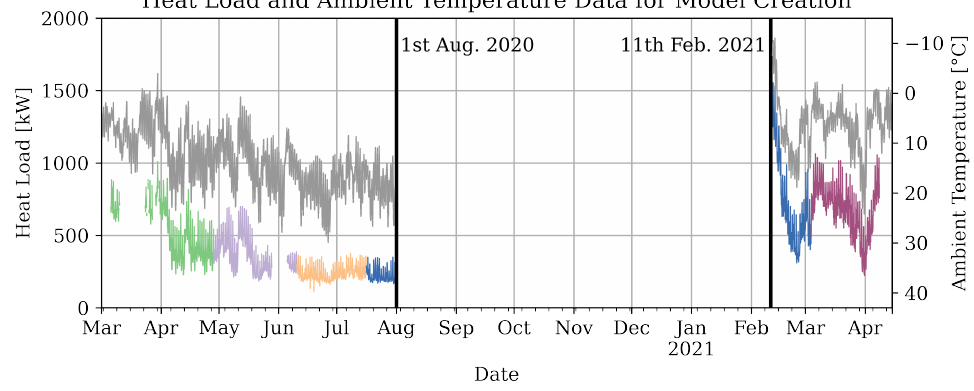
Figure 3. Heat load (colored) and ambient temperature data (grey) available for model development. The five different test sets from the five-fold nested cross-validation are highlighted by different colors in the heat load data. The period between 1 August 2020 and 11 February 2021 was removed for later application of the developed forecast models.